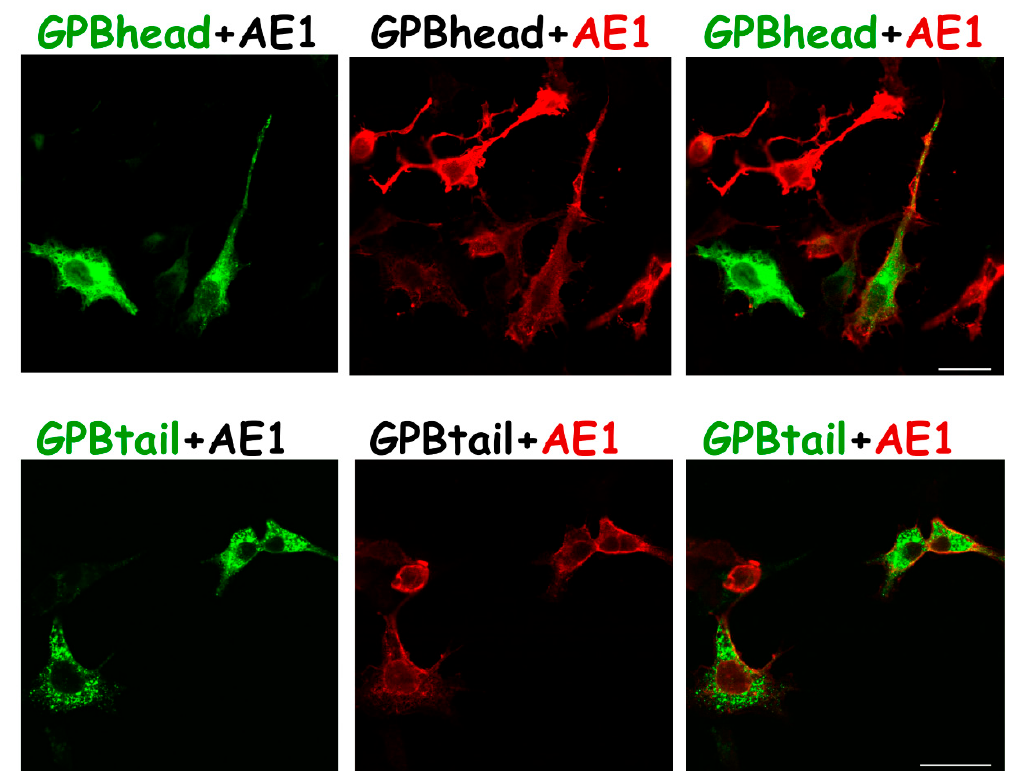
Figure 6. Subcellular localization of GBhead-GFP or GBtail-GFP was not affected by AE1 coexpression, suggesting that there was not even remote interaction between AE1 and the partial GPB structure. (TOP) HEK-293 cells were cotransfected with equal copy number of pGPBhead-GFP and pcAE1 plasmids, followed by immunolabeling with mouse anti-AE1 and then AF568 conjugated anti-mouse mAb. Similar to the GPBhead-GFP expression alone (Figure 5C), the distribution of GPBhead-GFP in AE1-coexpressed cells remained largely cytosolic and did not show any association with AE1 on the cell membrane. (BOTTOM) HEK-293 cells were cotransfected with equimolar pcAE1 and pGPBtail-GFP plasmids, followed by the same immunolabeling protocol to track AE1, as described above. Scale bar = 25 μ m.